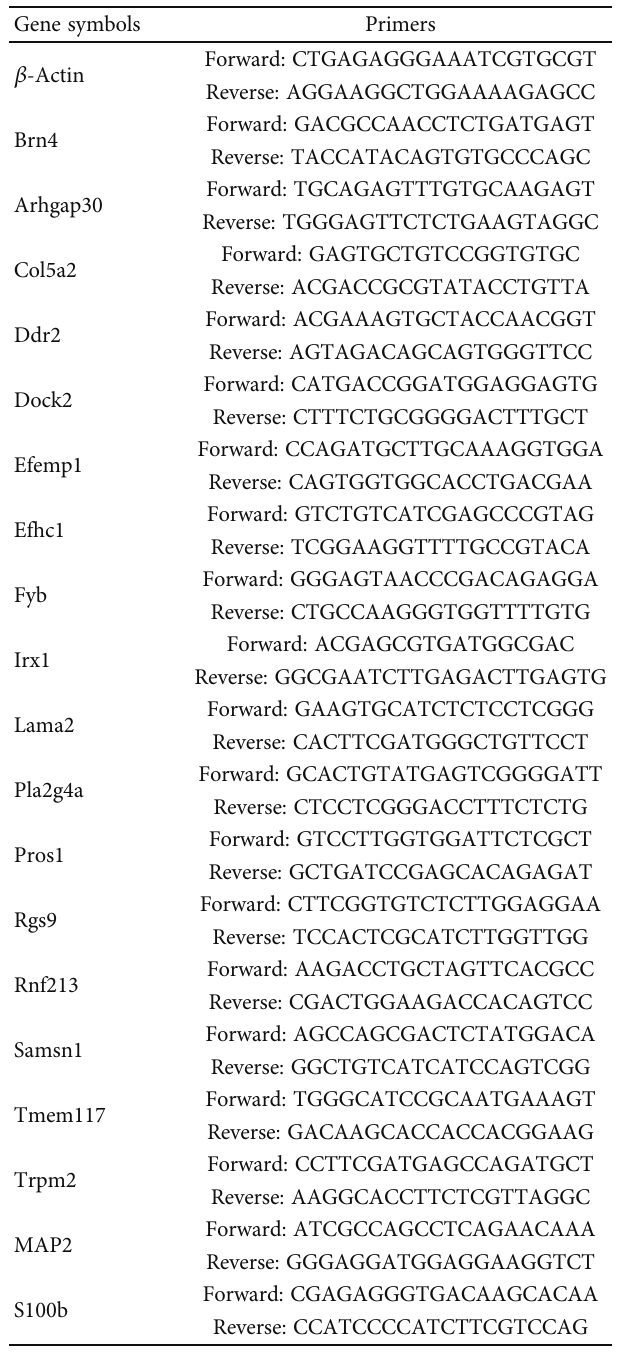
Table 2: The primer sequences used in the RT-qPCR. Gene